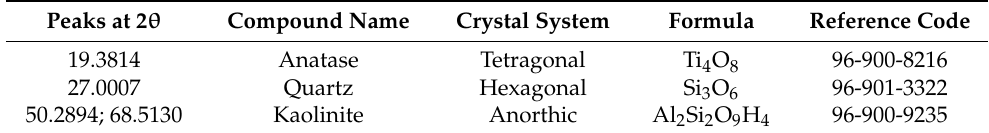
Table 3. Crystalline phases of kaolin.